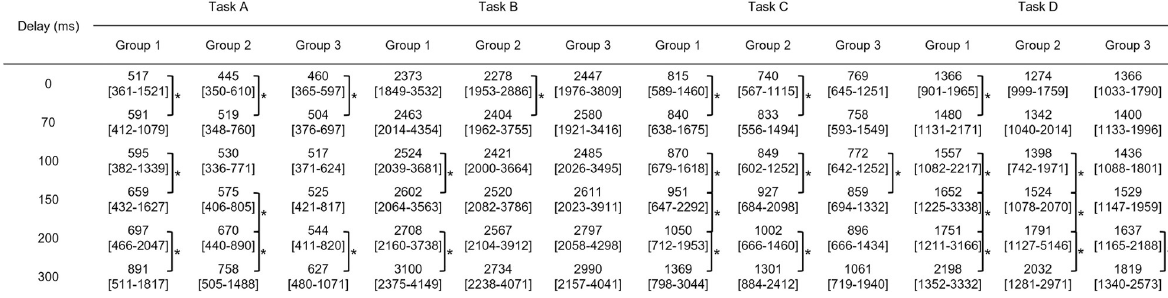
Fig 6. Total movement distance of forceps for each group under each delay. � shows significant difference (P value < 0.05). Values are median [minimum-maximum].